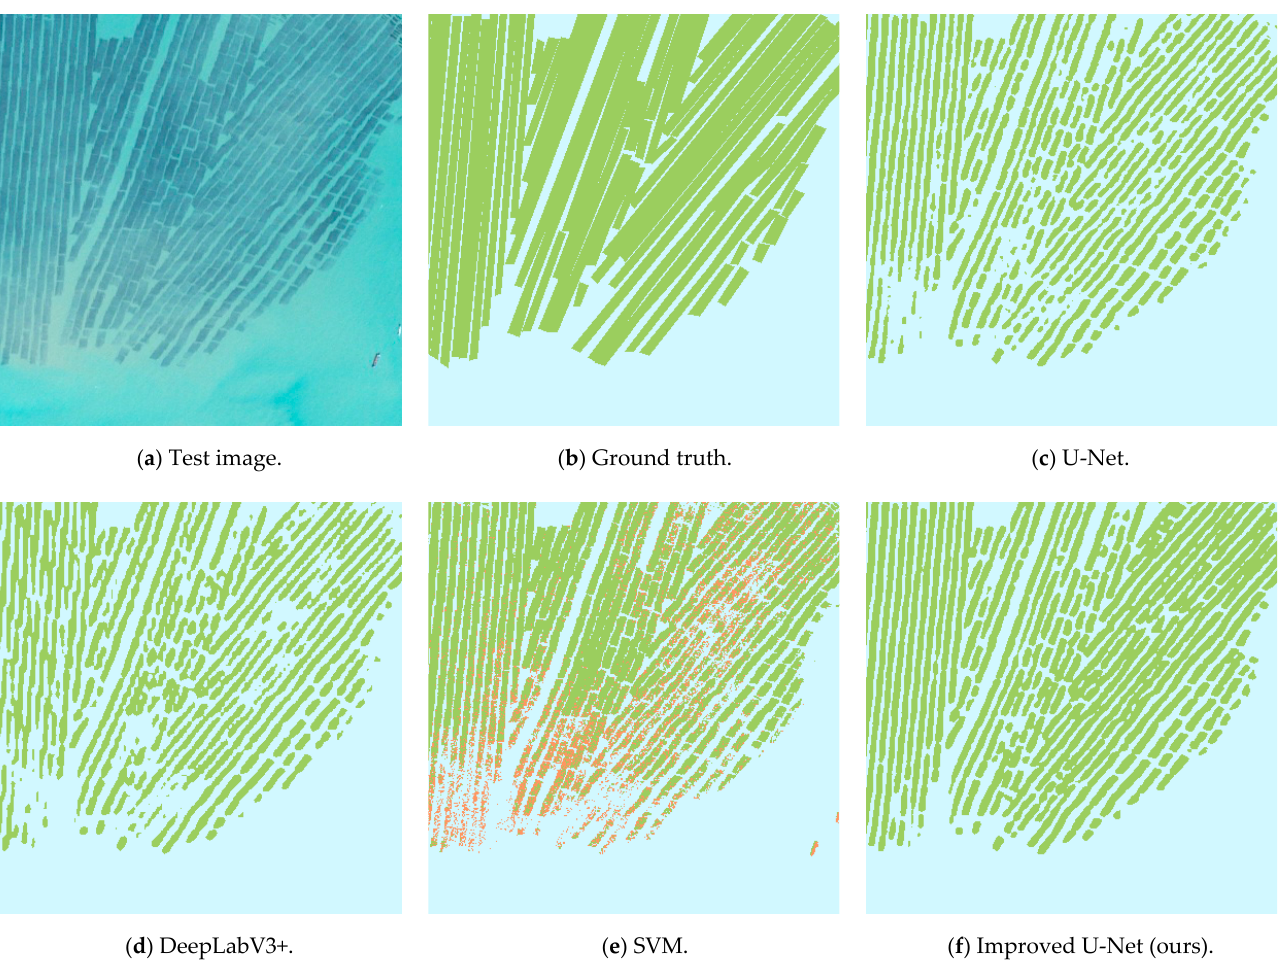
Figure 7. Compare the classification results of different models in another typical region. In the figure, the orange area represents the cage culture area; the green area represents the floating raft culture area; and the blue area represents the background. Table 1. Accuracy evaluation table of classification results of different models; the best value is